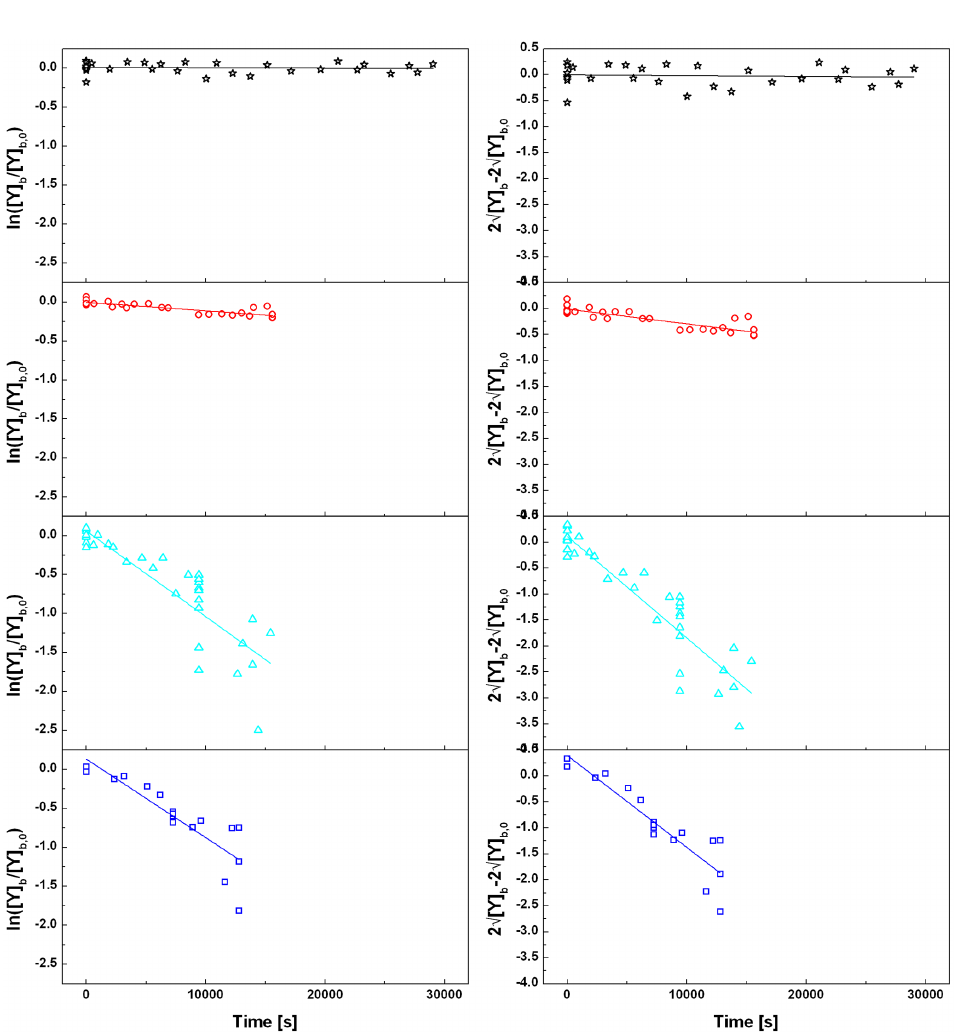
Figure 4. Linearized plots for pseudo-first-order volume limited (left) and reacto-diffusion limited reaction (right); linearized plots for the reacto-diffusive case: 12% RH (black stars, 3 . 2 × 10 − 6 atm), 52% RH (red circles, 6 . 1 × 10 − 6 atm), 71% RH (light blue triangles, 5 . 3 × 10 − 6 atm) and 82% RH (blue squares, 2 . 6 × 10 − 6 atm). The slope of the linear fit equals the corresponding rate